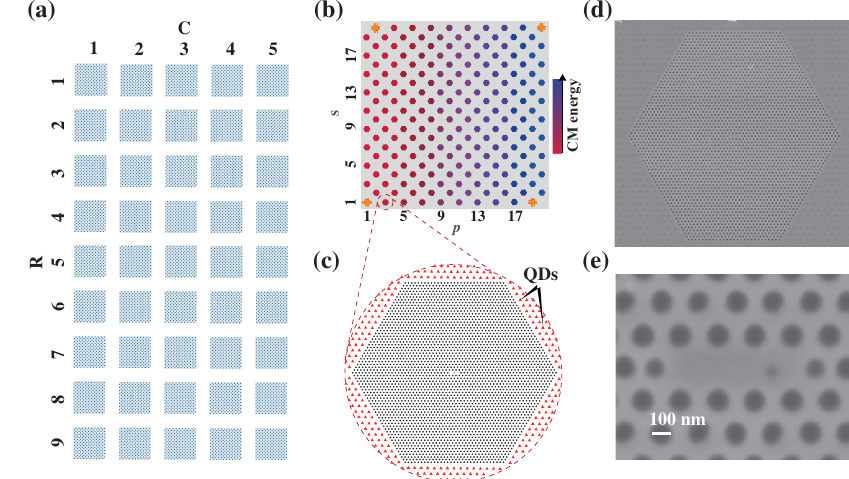
FIG. 7. Sample design. (a) An arrangement of 45 square arrays of PC cavities in 9 rows with 5 columns. (b) An arrangement of 200 PC cavities in a single array. (c),(d) A sketch and a SEM micrograph of an L 3 PC cavity integrated with a single QD. (e) SEM of a PC cavity with a visible QD position. Sacrificial QDs arranged in a triangular lattice with a period twice that of the PC hole lattice are removed by the PC cavity holes as visible in